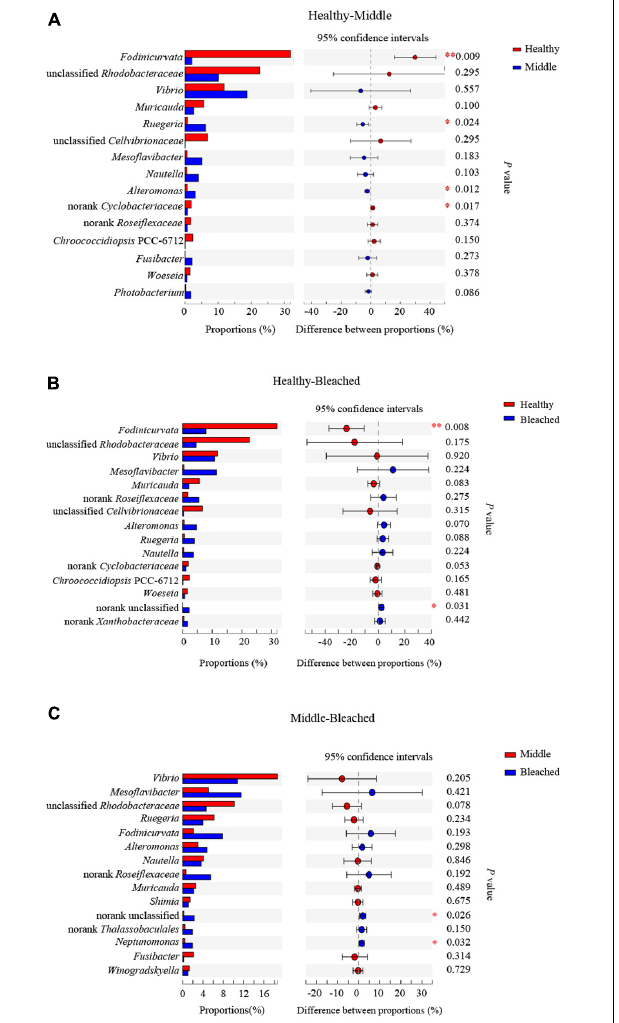
FIGURE 5 | Post hoc testing of bacterial genus groups with significant differences (A) between healthy and middle groups, (B) between healthy and bleached groups, and (C) between middle and bleached groups. ∗ p ≤ 0.05 and ∗∗ p ≤ 0.01.